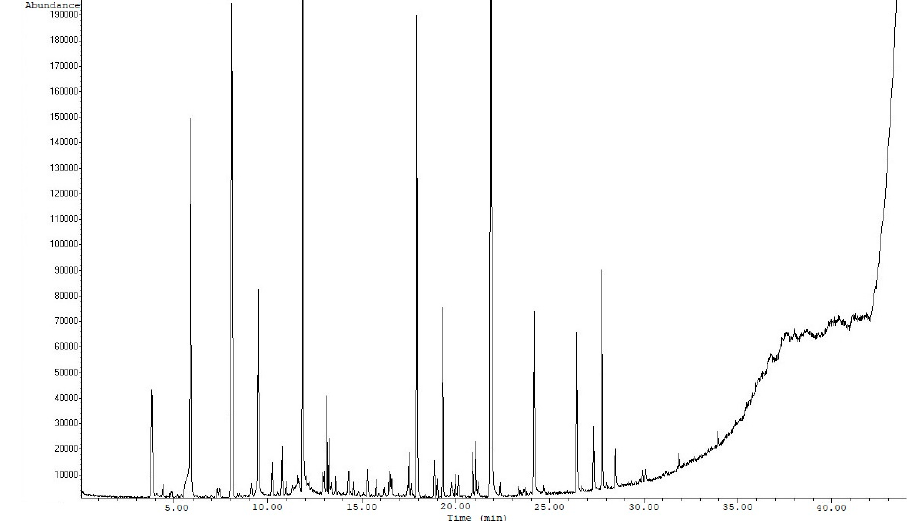
Figure 6. Chromatogram of walnut drink analysis.